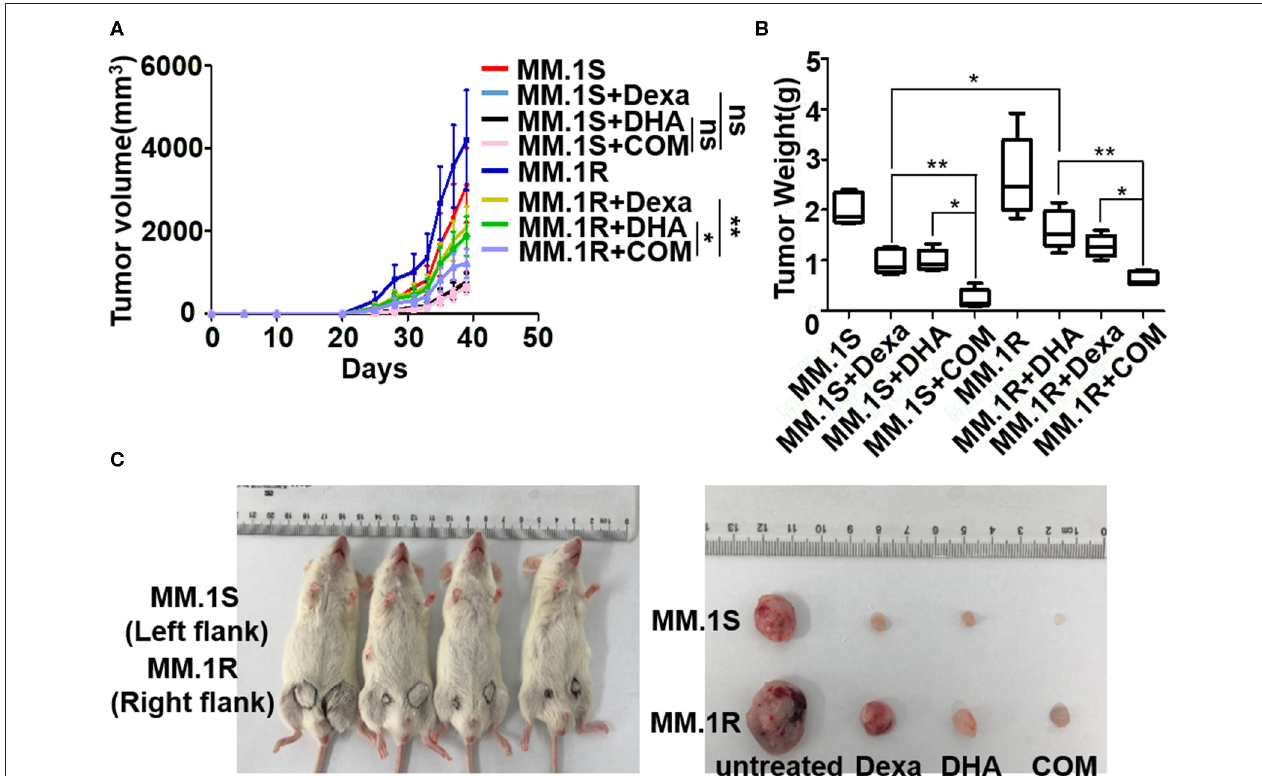
FIGURE 6 | Anti-MM activity of DHA in combination with Dexa in MM xenograft mouse models. (A) The effect of DHA combined with Dexa (COM) was examined in subcutaneous transplantation mouse models using MM.1S and MM.1R cell lines. The result indicated that COM significantly inhibited MM.1R tumor growth compared with the DHA and ART group. (B) After treatment, the tumor weight of COM group was lower than that of the DHA or ART group. * P < 0.05, ** P < 0.01. (C) The NOD-SCID mice injected subcutaneously with MM.1S (left) and MM.1R (right) cells were sacrificed and tumors were isolated on Day